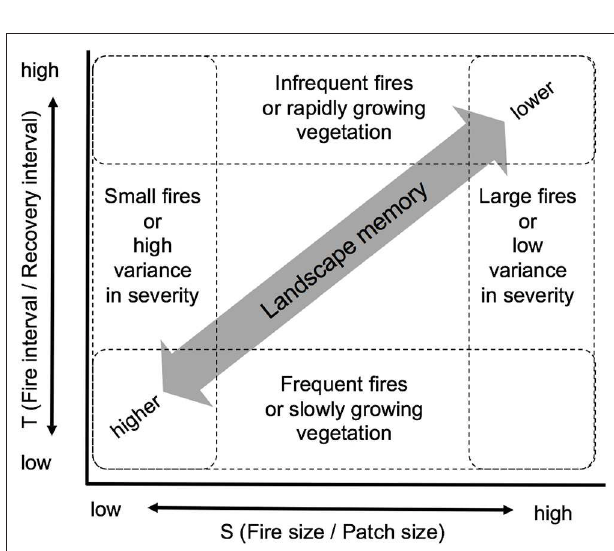
FIGURE 3 | Relationships between landscape memory and scales of time (T) and space (S) of landscape disturbances. The “landscape memory” of a disturbance decreases as the ratio of disturbance interval to recovery interval increases, and the ratio of disturbance size to patch size of the affected landscape increases. Revised, with permission, from McKenzie et al.